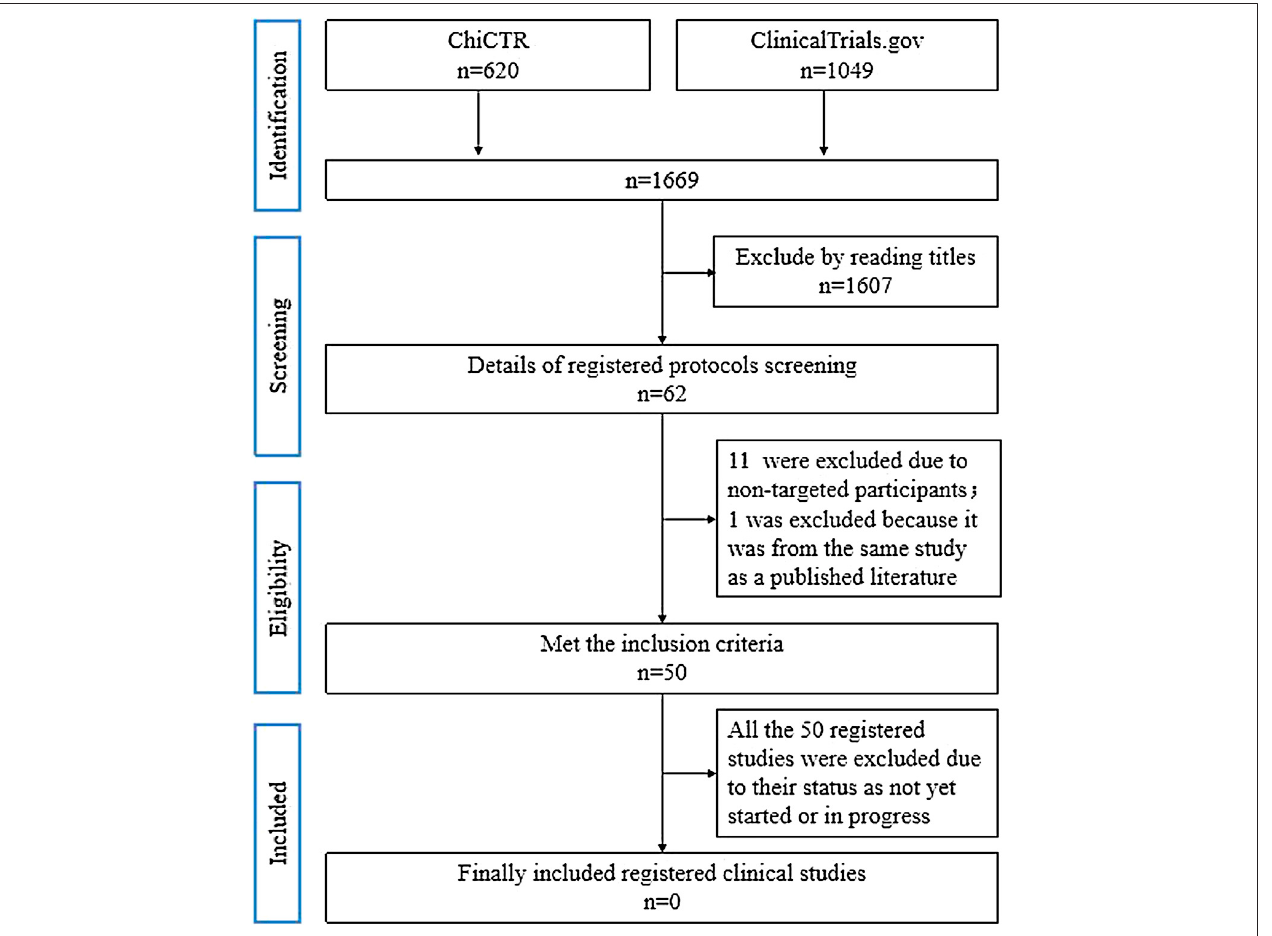
FIGURE 2 | Flow diagram for searching and screening of registered clinical studies.